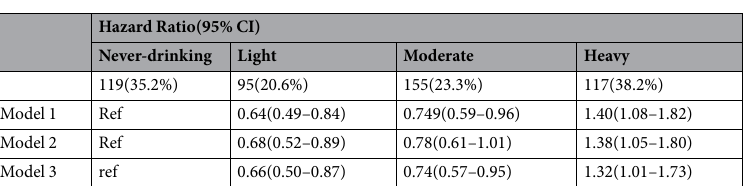
Table 3. Association between alcohol consumption pattern during follow-up period and 12-year incidence of type 2 diabetes. The participants were categorized into four groups based on follow-up measurement (consumption pattern). Model 1: adjusted for age and Body mass index. Model 2: adjusted for age, Body mass index, family history of diabetes, and smoking. Model 3: adjusted for age, Body mass index, family history of diabetes, smoking, physical activity, total energy intake and IGI 60